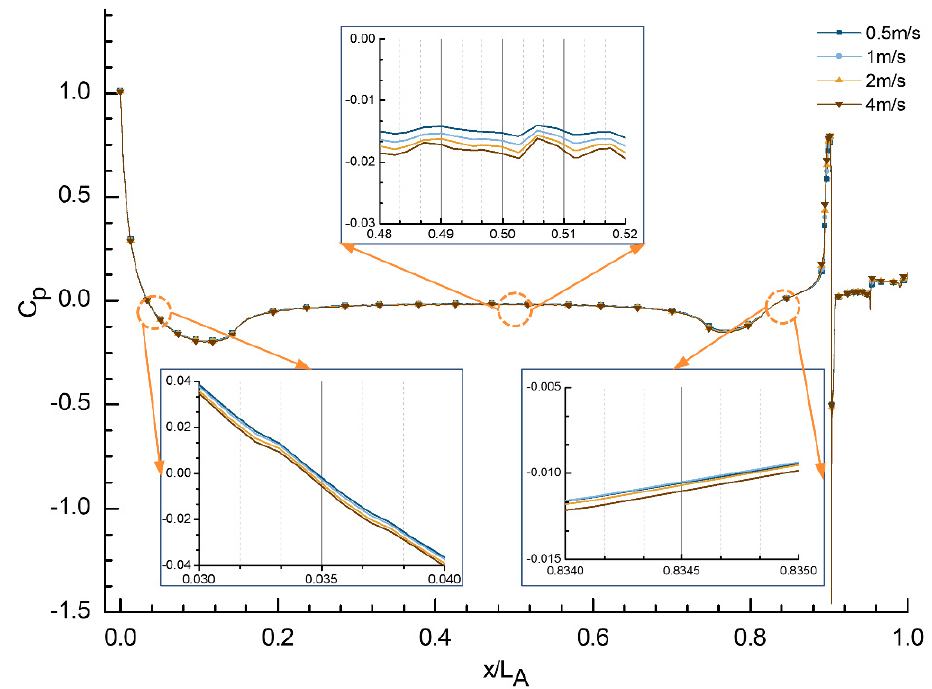
Figure 10. (cid:1829) (cid:1868) distribution of bare UUV at cross section a for different (cid:1844)(cid:1857) (cid:3013) . Figure 10. C p distribution of bare UUV at cross section a for different Re L